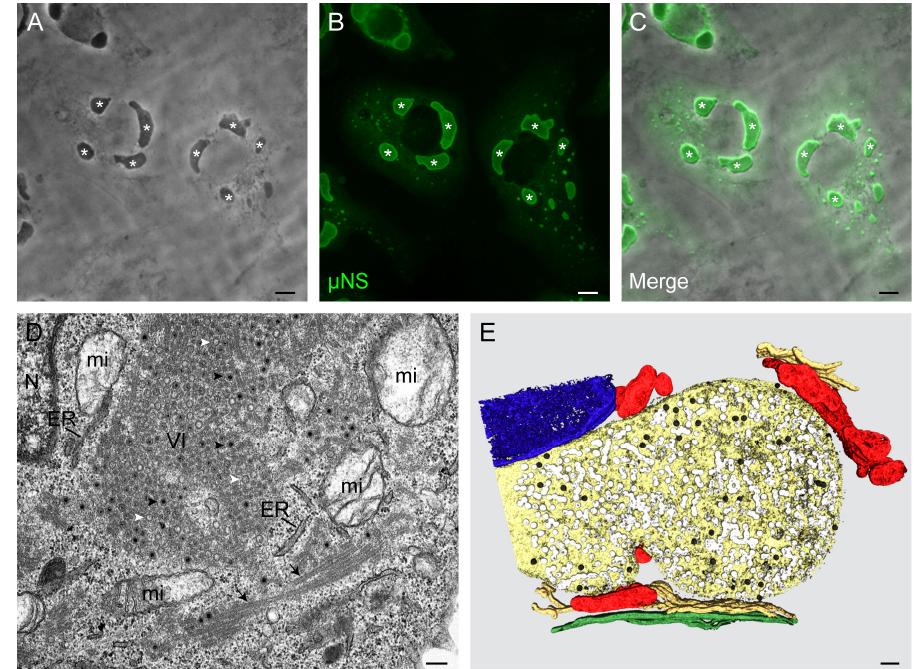
Figure 2. Reovirus inclusions imaged by light and electron microscopy. ( A – C ) Human brain microvascular endothelial cells were infected with reovirus strain T1L M1-P208S for 24 h, and were fixed, permeabilized, and processed for immunofluorescence staining with a chicken anti- µ NS polyclonal serum and a secondary antibody conjugated with Alexa 594 (green). This strain forms large, globular VIs. ( A ) The phase-contrast microscopy shows dark, dense, globular structures (asterisks) in the cytosol of reovirus-infected cells. ( B ) The localization of µ NS by fluorescence microscopy confirms that the dense structures seen by phase-contrast microscopy are viral inclusions (asterisks). ( C ) The merging of phase-contrast and fluorescence microscopy images. ( D , E ) HeLa cells were infected with T1L M1-P208S and fixed at 24 h. ( D ) Ultrathin sections (~70 nm) of infected cells were imaged by transmission electron microscopy (TEM). A characteristic viral inclusion (VI) is shown. The VI contains mature virions (black arrowheads) and empty viral particles (white arrowheads). Mitochondria (mi), endoplasmic reticulum (ER) cisternae, and microtubules (arrows) surround the VI. N—nucleus. ( E ) VI as visualized by TEM of serial sections, 3D reconstruction, and image processing. The mitochondria (red) and ER cisternae (gold) surround a network of smooth membranes (light yellow) with mature virions (black) and empty viral particles (white). The nucleus is colored in blue and the microtubules in green. Scale bars are 10 µ M in ( A – C ) and 250 nm in ( D , E